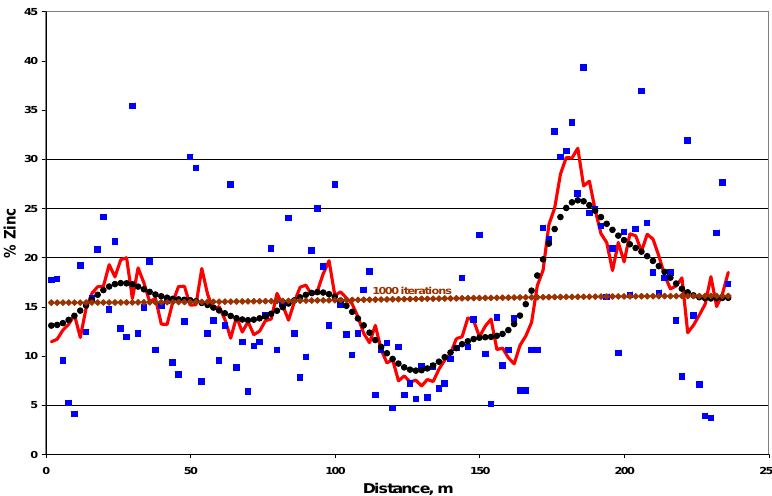
Fig. 18. Results of applying iterative method of Chen et al. (2007) augmented by continuing iteration process until full convergence is reached. Original zinc values (blue) are being smoothed during successive iterations. Second series (red line) obtained after first iteration resembles “signal” in Fig. 1. Values obtained after 4 iterations are shown as black diamonds. At the end of the process, after 1000 iterations when convergence has been reached, the result is approximately a straight line (brown diamonds) with average value slightly below average zinc content ( = 15.61% Zn).